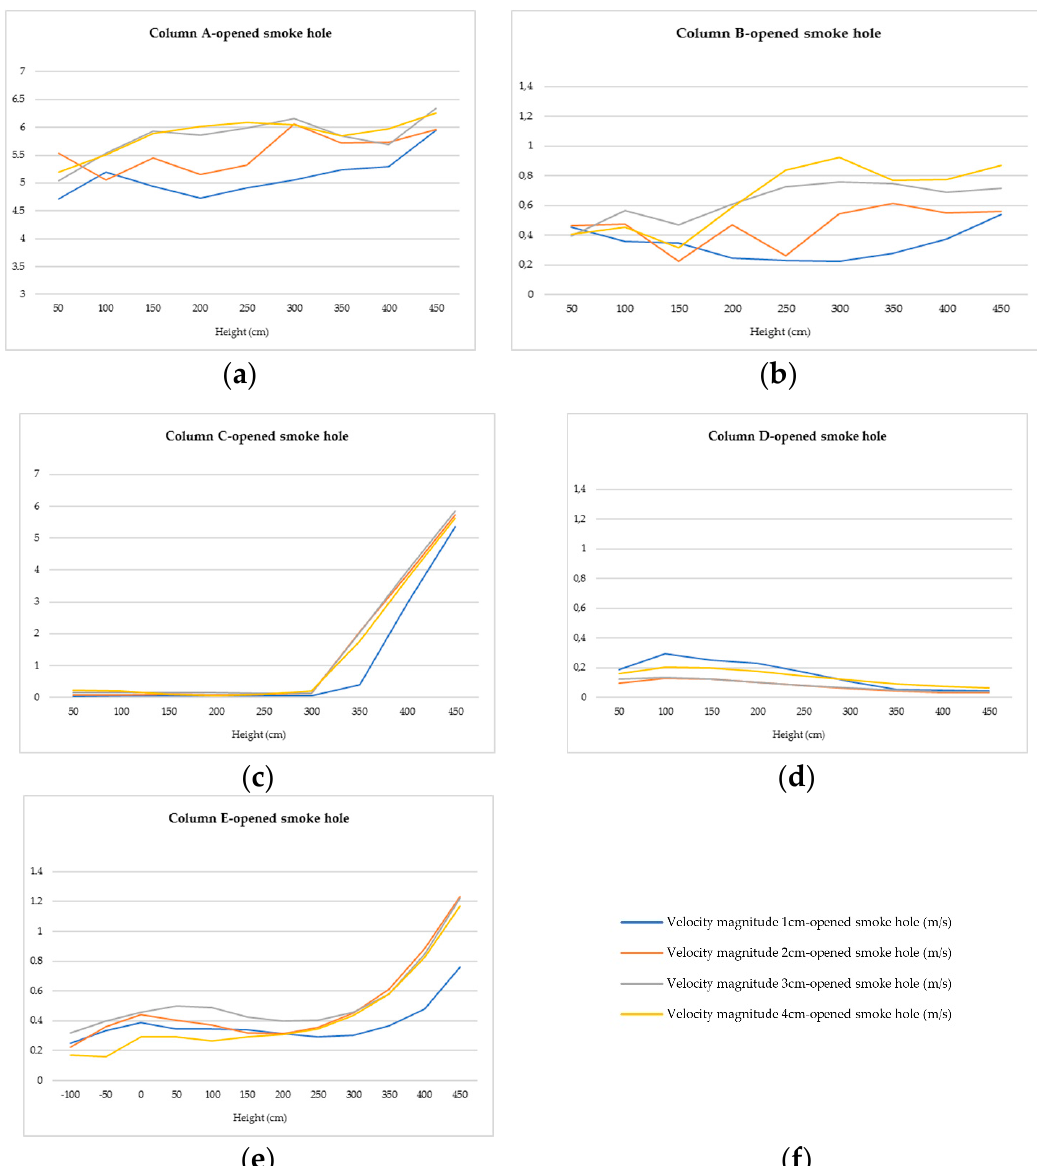
Figure 8. Values of velocity for the five columns of points, which is analyzed when the smoke hole of the plank house is opened (m/s) (Microsoft Excel ® ; Autodesk CFD ® ).